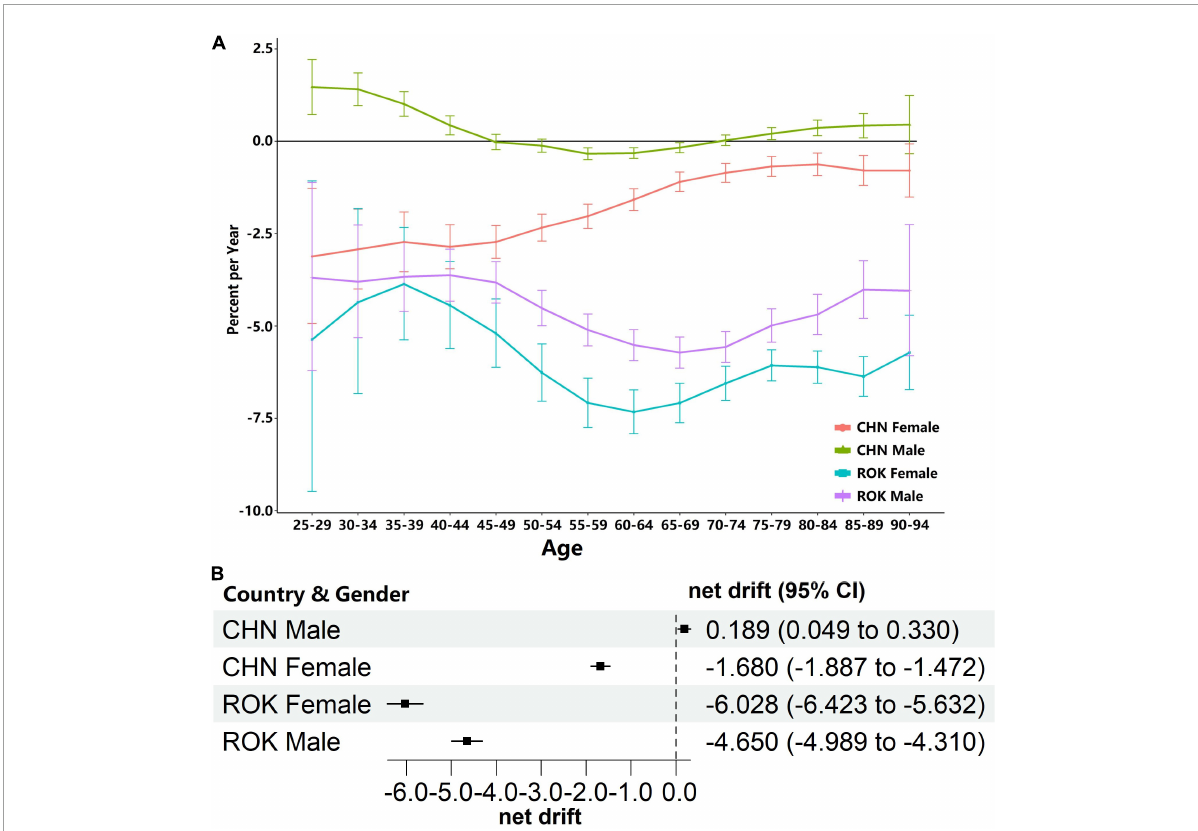
FIGURE2 Local and net drifts of HRMI attributable stroke mortality (error bars stand for 95% confidence intervals) for both genders in China (CHN) and South Korea (SK) from 1994 to 2019. (A) The local drifts for both genders in China and Korea along with age; (B) net drifts for both genders in China and Korea from 1994 to